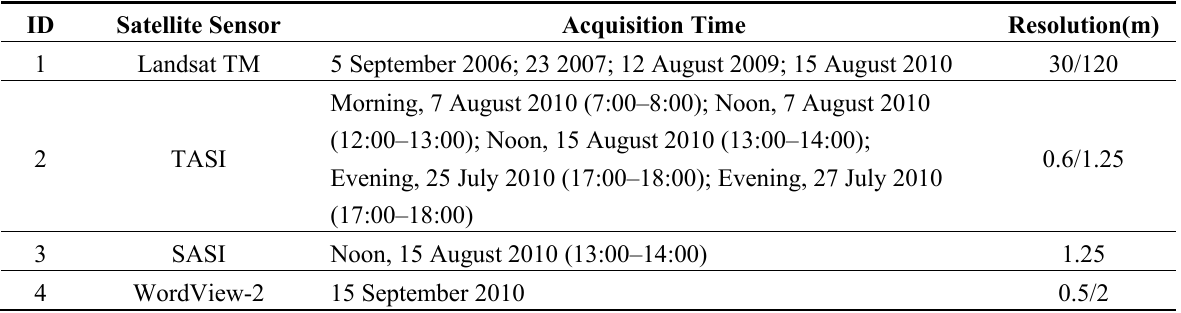
Table 2. Characteristics of the data used in this study (the overpass time is in local